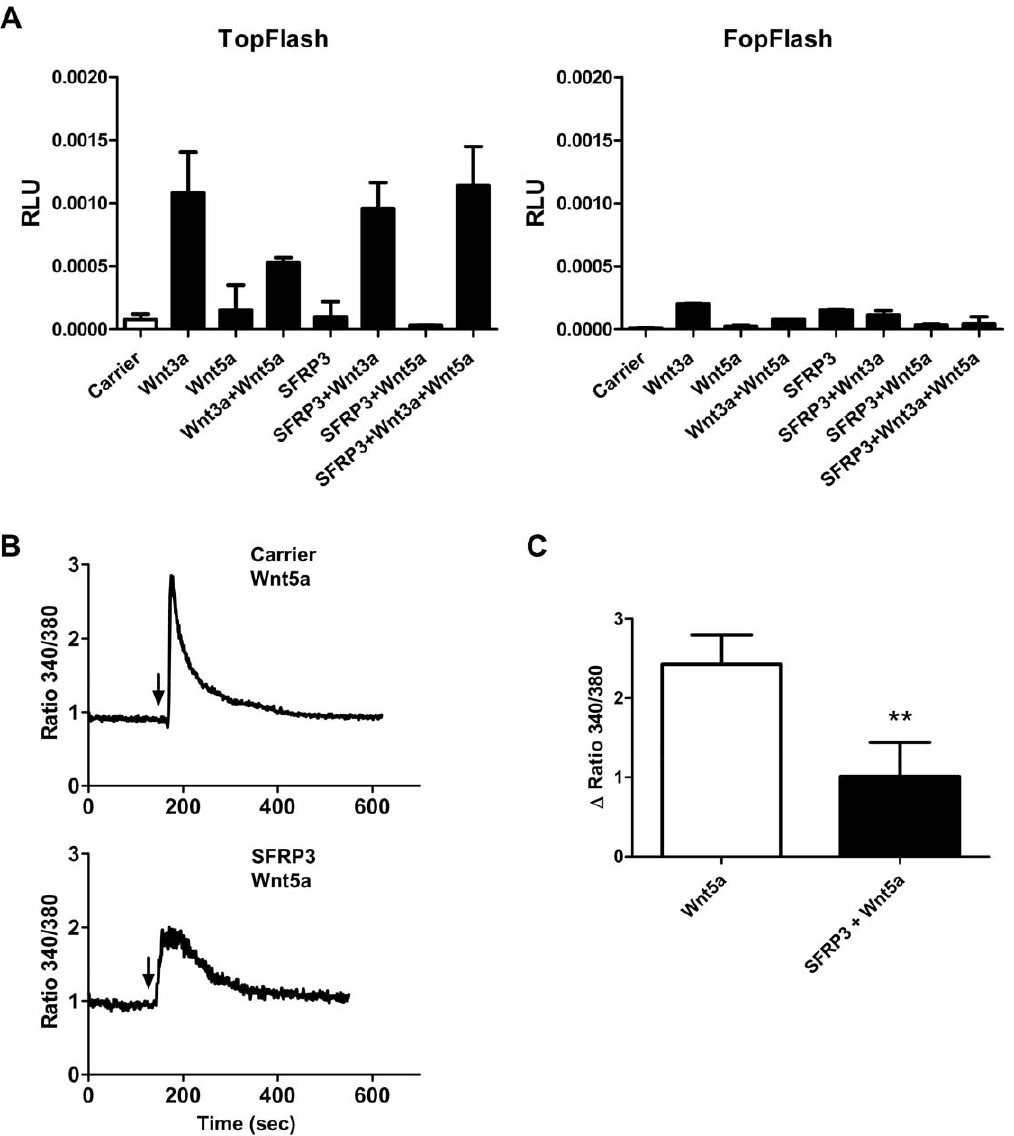
Figure 4. SFRP3 can inhibit Wnt5a signaling. A , Topflash reporter assay. A2058 cells transiently transfected with Topflash and Fopflash plasmids. Where appropriate, cells were pre-treated with 1 m g/ml rSFRP3 or carrier, and after 24 h cells were treated with the indicated combinations of Wnt ligands (0.2 m g/ml rWnt5a and 0.05 m g/ml rWnt3a) as indicated for an additional 24 h. The image is representative of 5 independent experiments and the error bars represent SD within one experiment. B , Measurement of intracellular Ca 2 + signaling. rWnt5a (0.1 m g/ml, addition indicated by arrows) was added to A2058 cells pre-treated with carrier (upper panel) or 1 m g/ml rSFRP3 (lower panel). Traces are representative images of 4 separate experiments. C , D Ca 2 + ratio values from A2058 cells pre-treated with either carrier or 1 m g/ml rSFRP3 and then stimulated with 0.1 m g/ml rWnt5a. Error bars represent SD (n=4). **=p , 0,01.